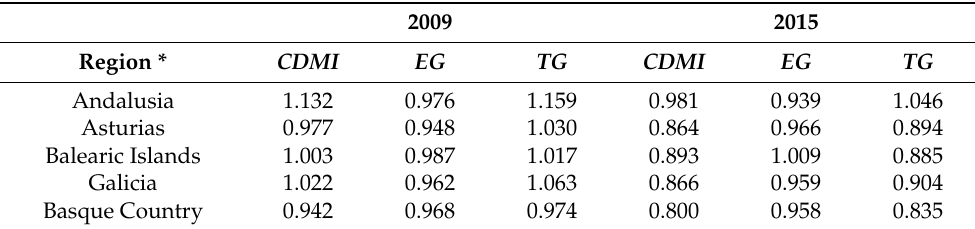
Table 6. Base-group CDMI productivity scores and